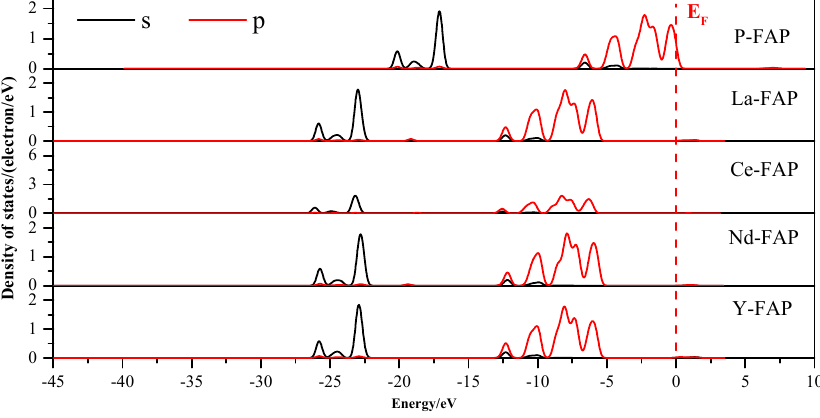
Figure 9. PDOS of a single O atom adjacent to the rare earth atom in REE-FAP crystals.